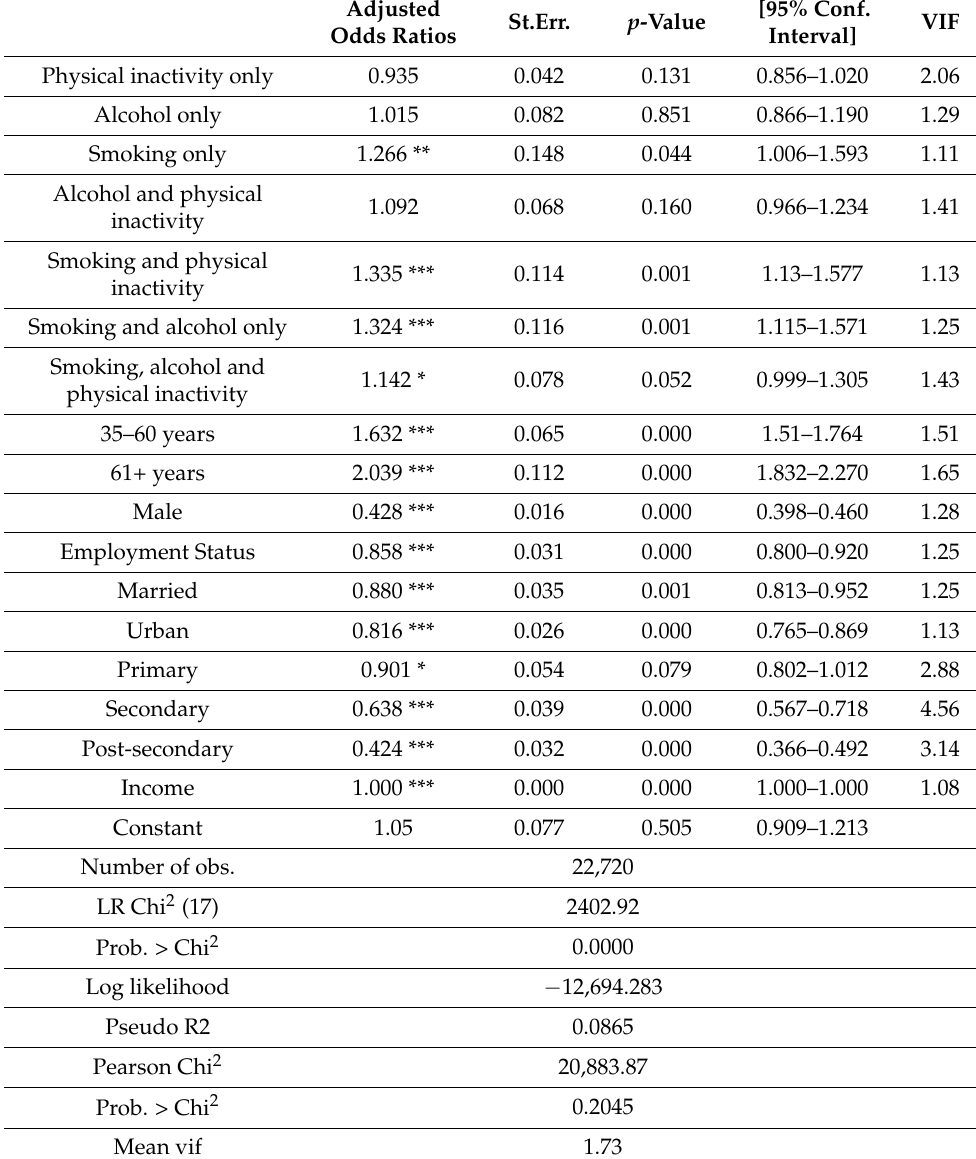
Table 5. Multivariate logistic regression result on effect of lifestyle risk factors on public